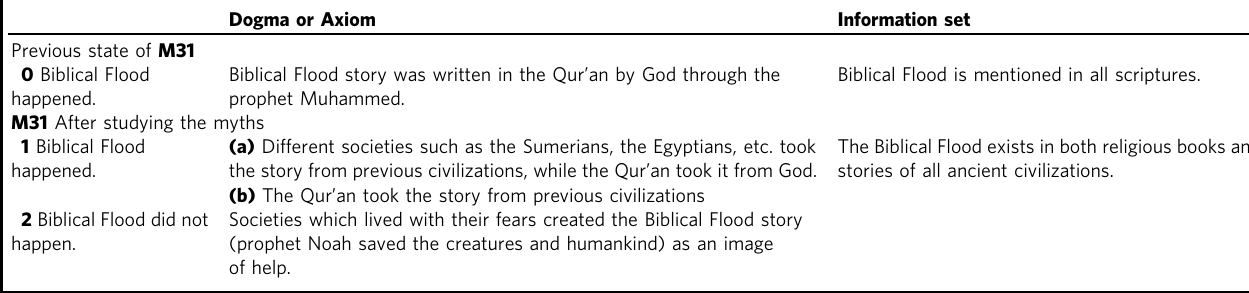
Table 2 Dogmatic options that appear for M31 when new information is